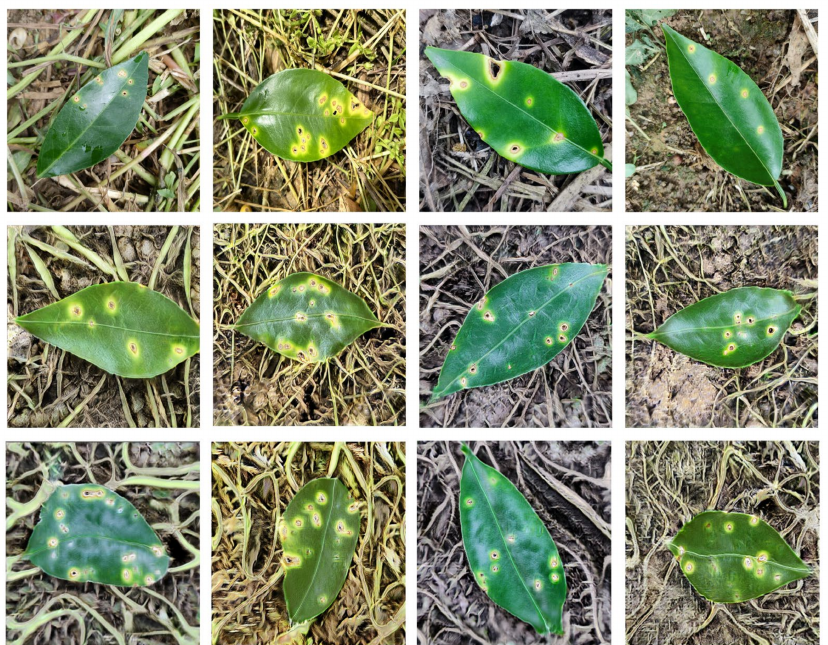
Figure 8. Comparison between the image generated by FastGAN and FastGAN2 and the original image with the complex background: “Real image”, “FastGAN2” and “FastGAN” images down the sides.